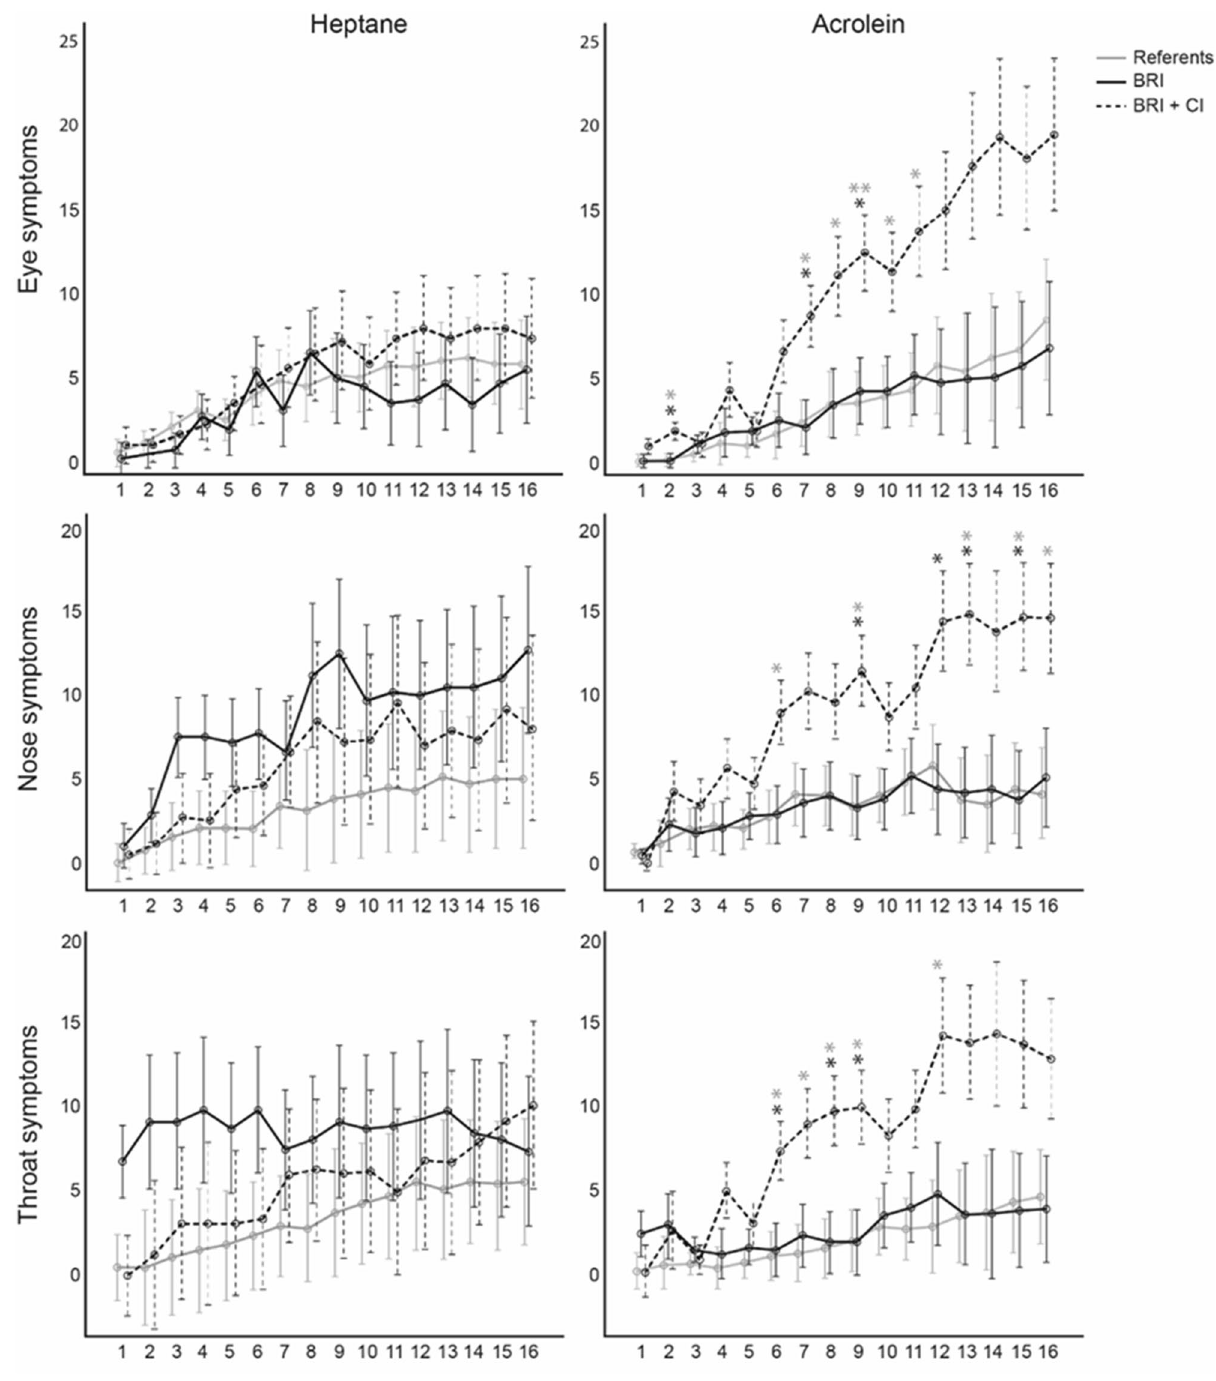
Figure 4. Estimated marginal means of difference scores of sensory irritation in the eyes, nose and throat over time in BRS + CI cases, BRS cases and referents when exposed to masked Acrolein and Heptane. Grey (BRS + CI vs. referents) and black (BRS + CI vs. BRS) asterisks refer to parameter estimates (* p < 0.05, ** p <